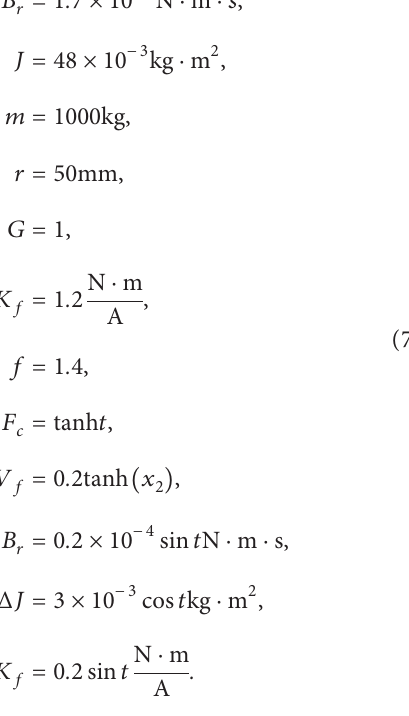
Figure 2: Responses of e